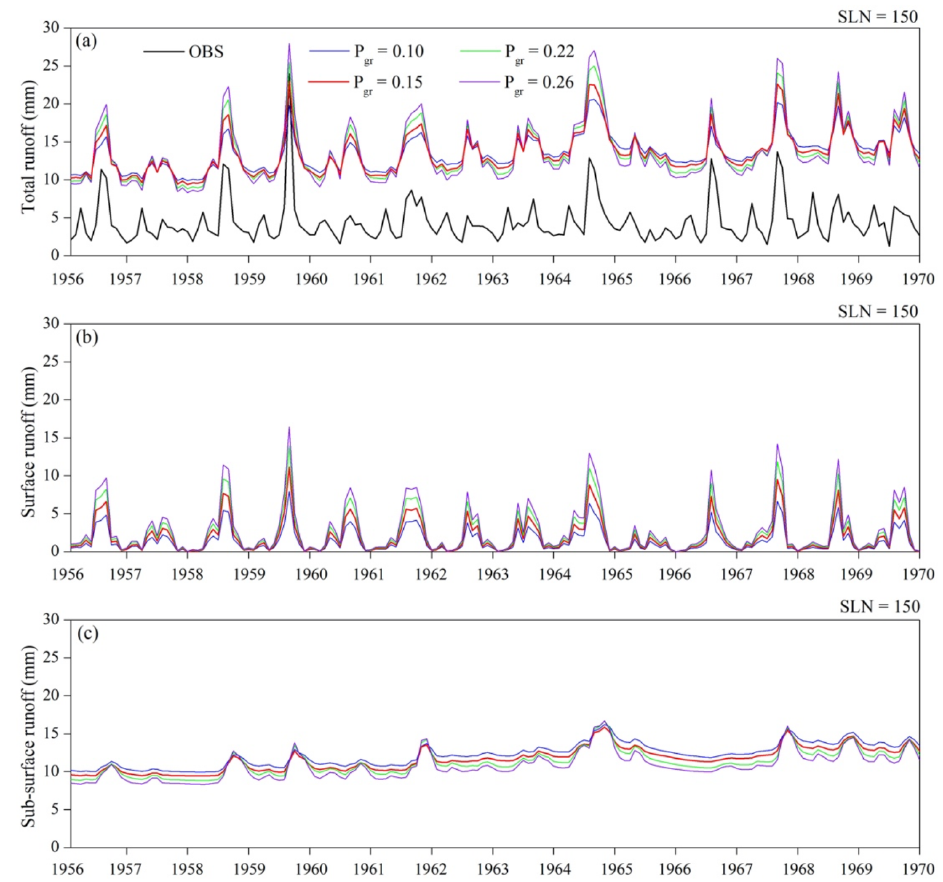
Figure 7. (a) Observed and simulated monthly runoff for the BJC hydrological station; (b) simulated surface runoff; (c) simulated subsurface runoff. All simulations were produced with different P gr values.